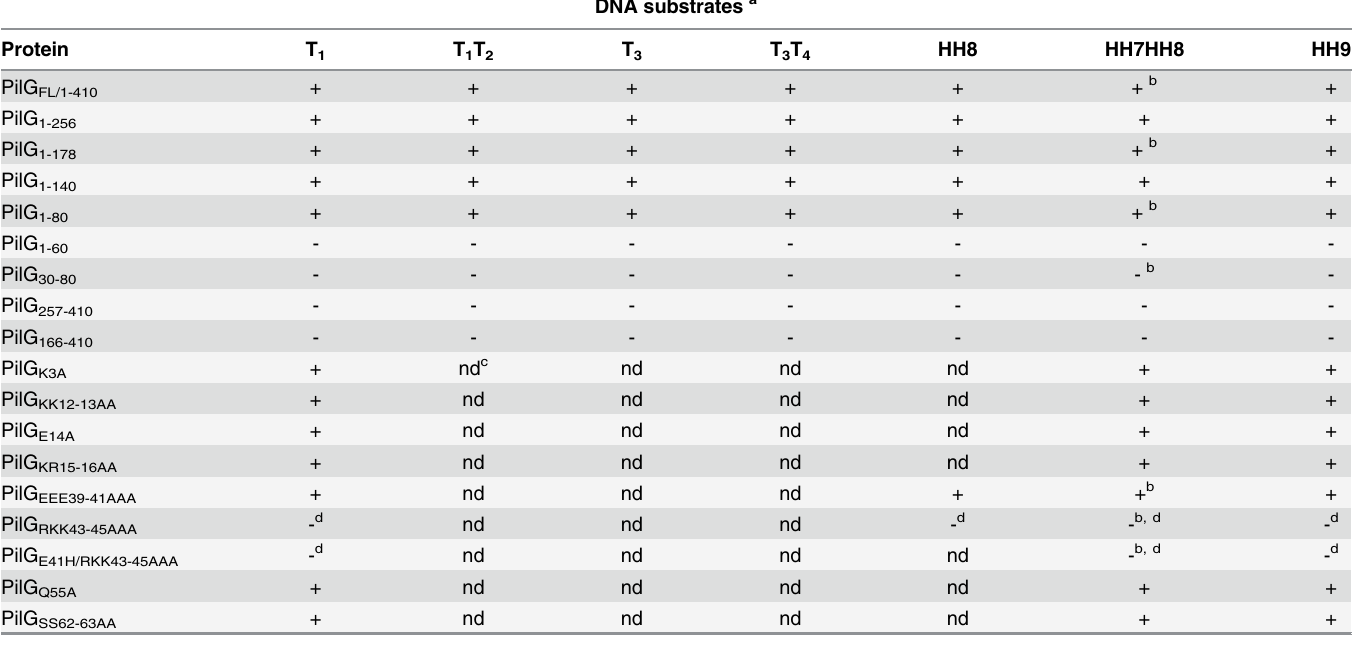
Table 3. Summary of the results of the oligo nucleotide binding tests using recombinant PilG proteins. The “ + ” and “ - ” refer to the DNA binding activity of the proteins when analyzed by South-western.